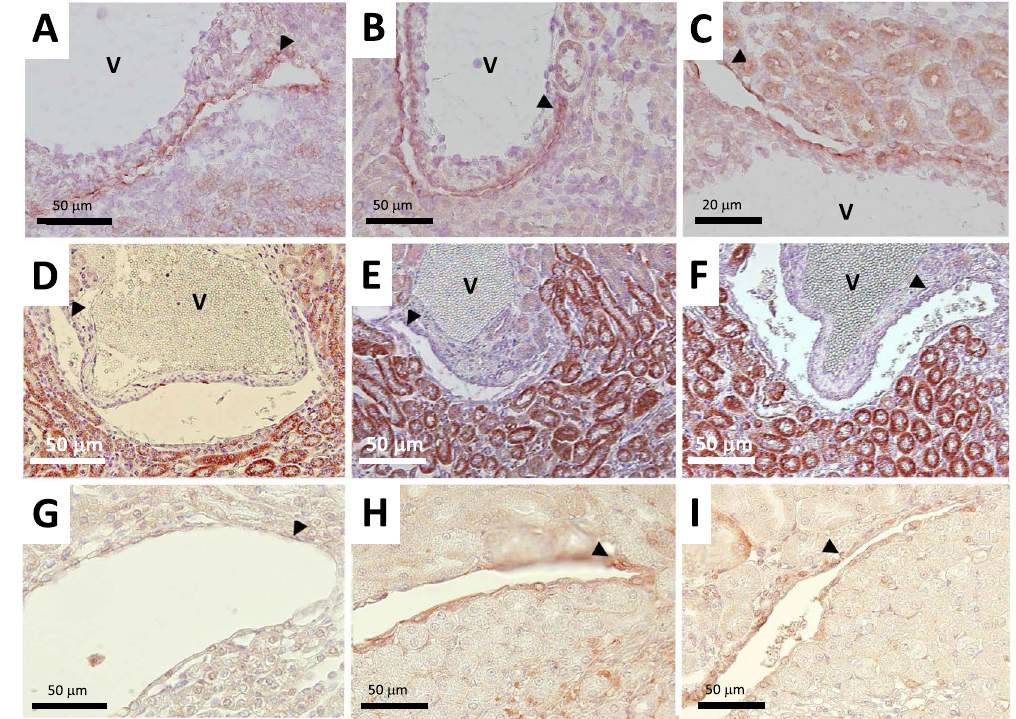
Figure 4. Localization of macromolecule inhibitors osteopontin OPN ( A – C ), hyaluronic acid HA ( D – F ) and Matrix Gla protein MGP ( G – I ) within kidneys on day 21. ( A , D and G ): control group. ( B , E and H ): HLP group. C, F and J: HLP + FGF7 group. Black arrows indicate urothelial cells surrounding urinary spaces which are collapsed in frozen tissue sections ( A – C ) and open in paraffin-embedded ( D – I ) kidney sections. A = artery. V =